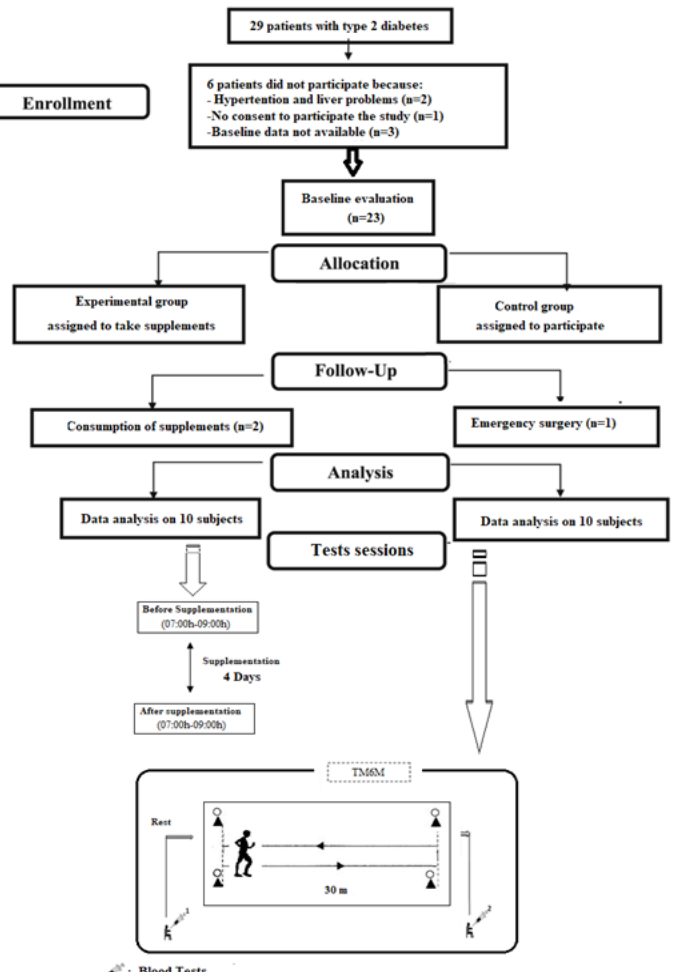
Figure 1. Flow-chart of participant